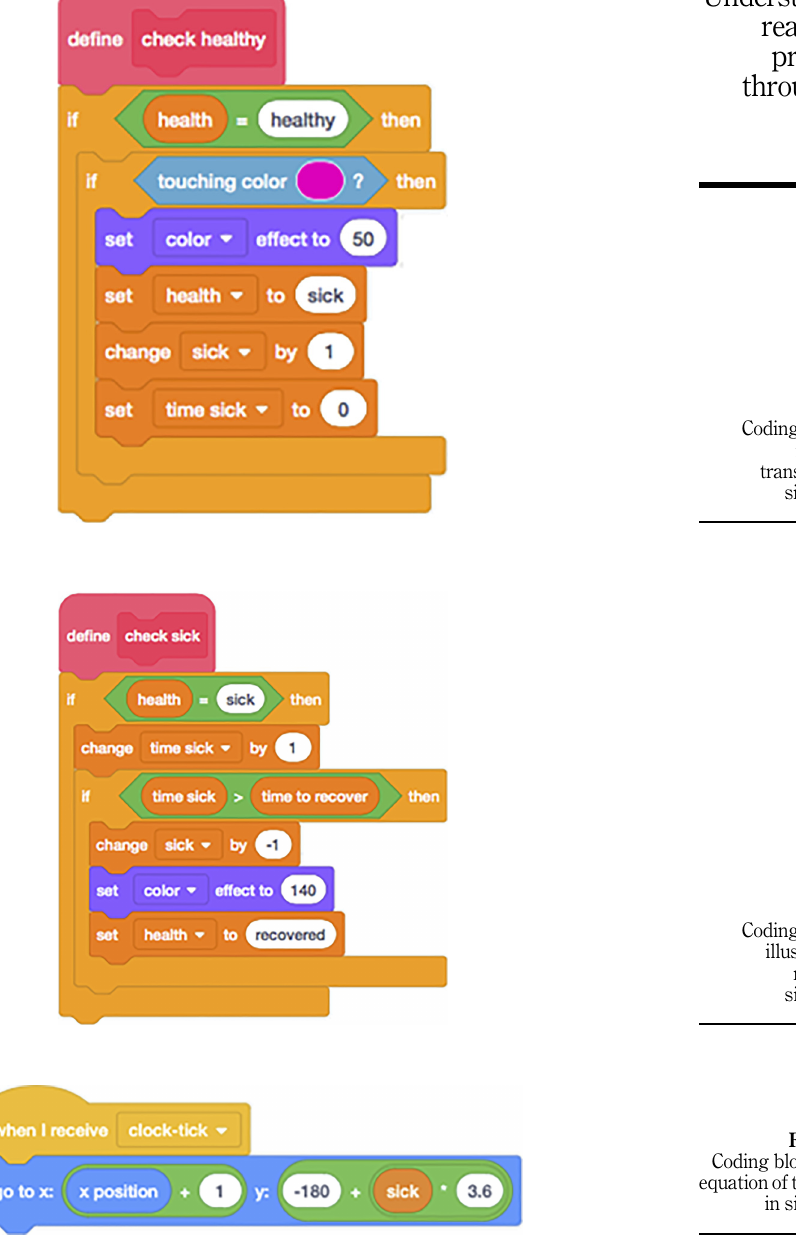
Figure 9. Coding blocks for illustrating the recovery in simulation 1